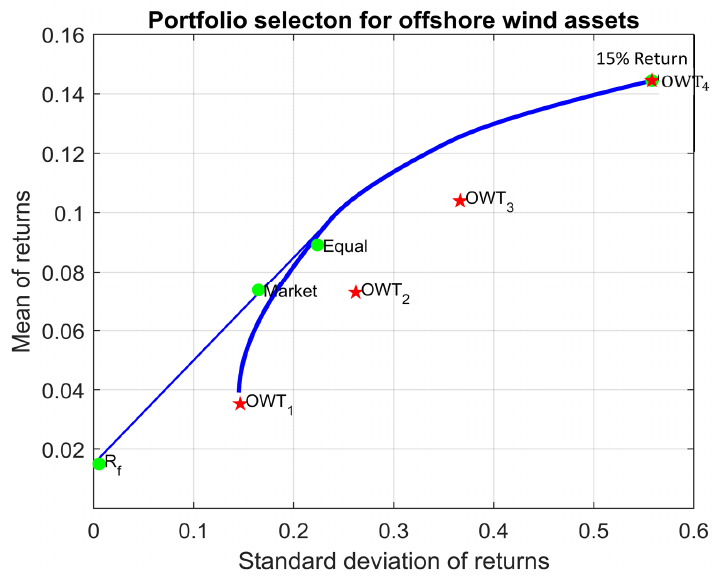
Figure 7. Mean value of returns as a function of standard deviation, 15% return and equal weights.